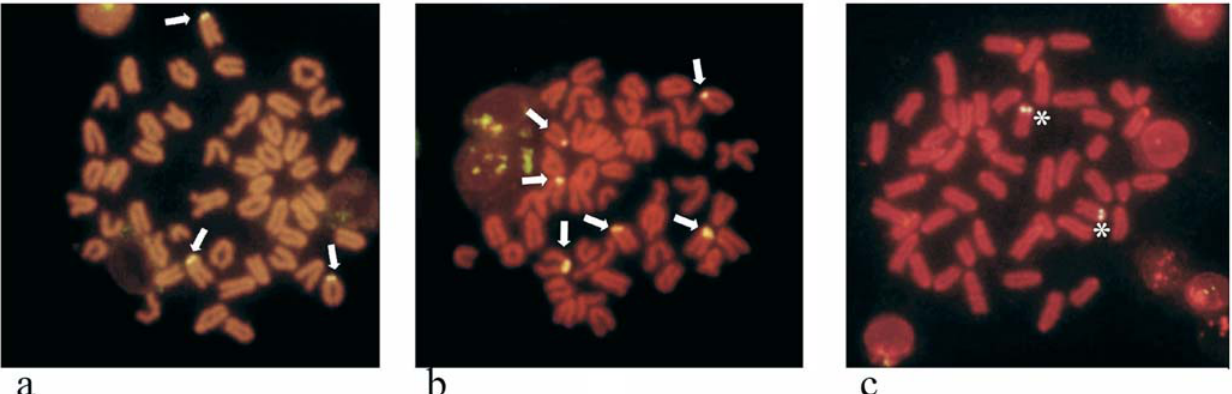
Fig. 6. Metaphases of Lutjanus griseus after FISH with 18S rDNA (arrows) in a female (a) and in a male (b) and (c) with 5S rDNA